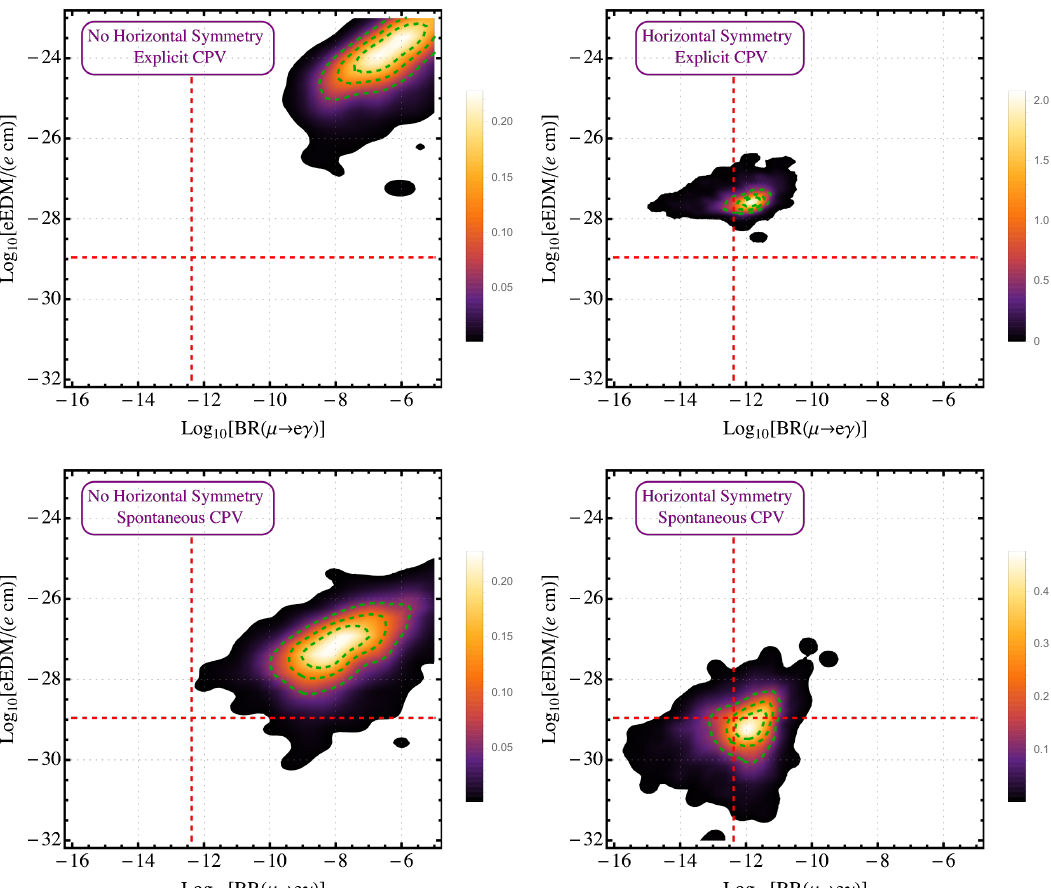
Figure 2 . The distribution of the prediction of four different extensions of the MSSM for the eEDM and BR ( µ → eγ ) . Dashed red lines indicate the current experimental upper bounds. We fix ˜ m = 10 M = 10 M = 10 TeV and t = 5 in all the scenarios. In each scenario, we fix the 1 2 β